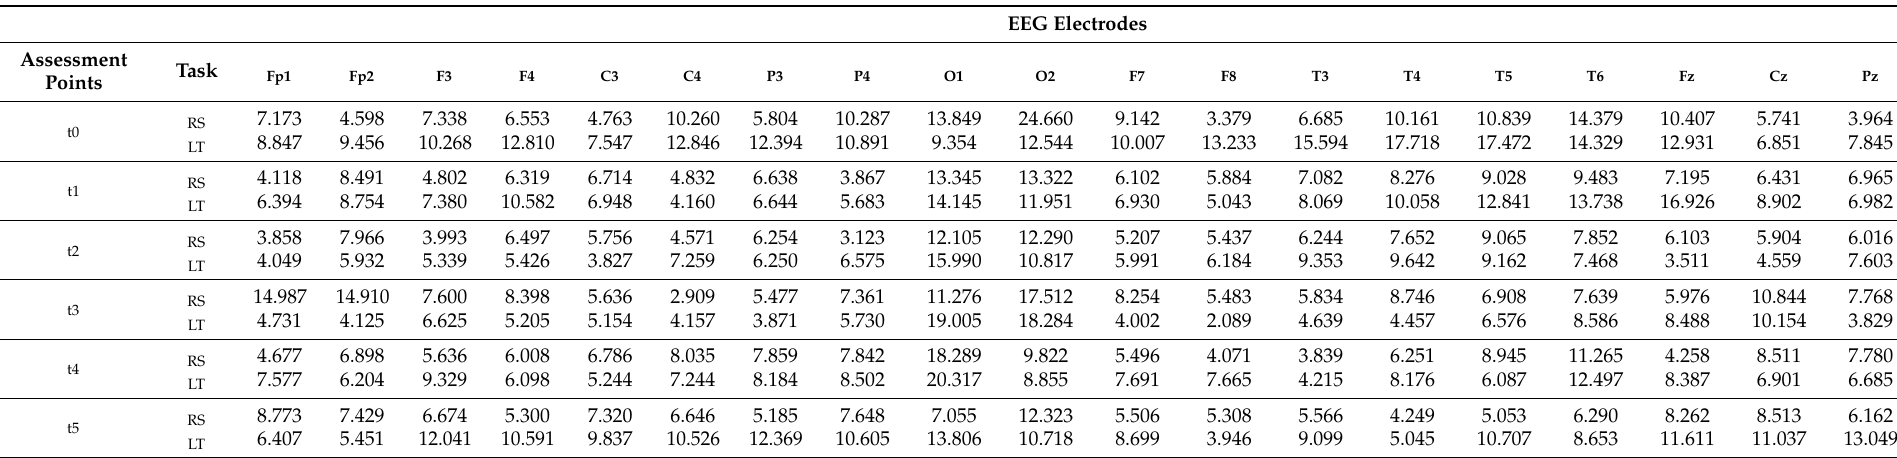
Table A1. EEG correlates of spectral power ( µ V2) mean values in theta rhythm during auditory-verbal